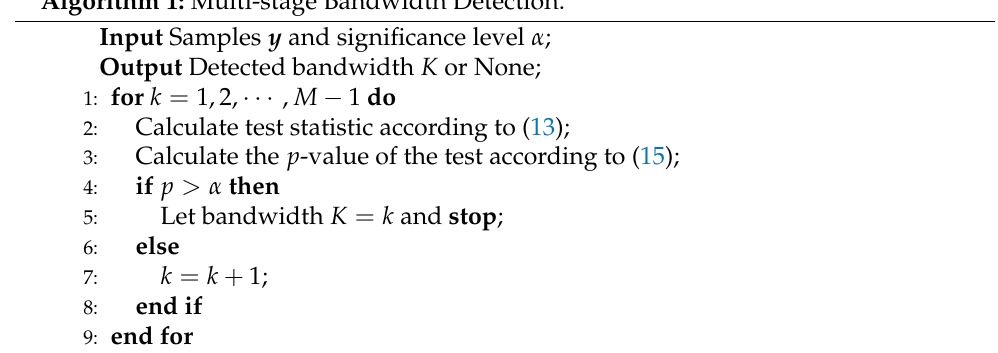
Algorithm 1: Multi-stage Bandwidth